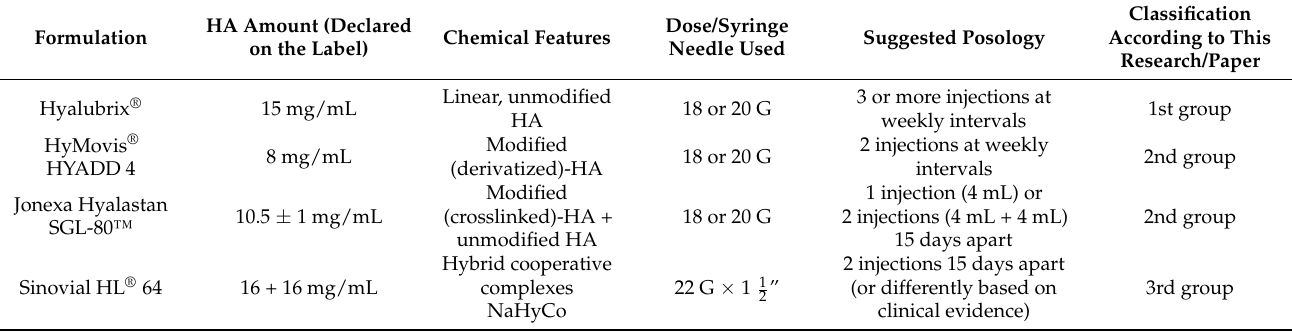
Table 1. Available information on the HA-formulations analyzed here, as reported in the leaflets [33,34,38,40,41]. Formulation Suggested Posology